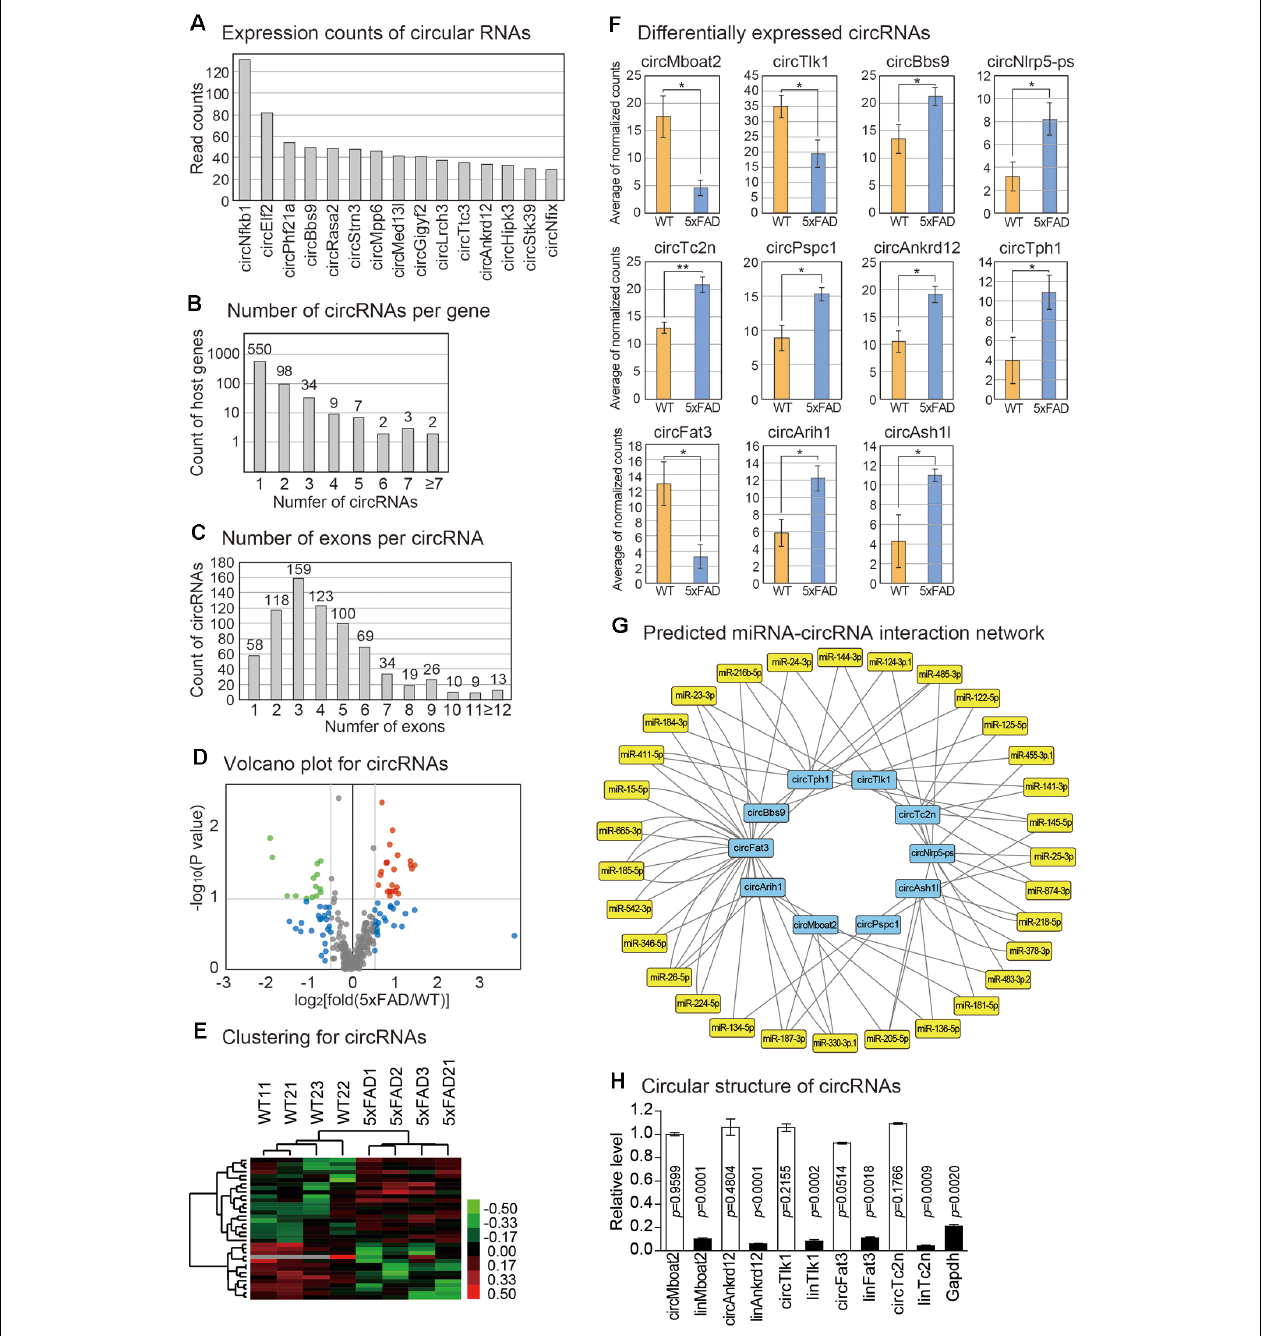
FIGURE 4 | Analysis of circRNA changes in the mouse pineal gland with AD. (A) Expression counts of 15 highly expressed circRNAs in the pineal glands. The average read counts among the wild type and 5xFAD samples were calculated. (B) Distribution of the number of circRNAs produced from each host gene. (C) Distribution of the number of exons used to produce each circRNA. (D) Volcano plot for circRNAs. Those genes with values of P < 0.1 and those with expression changes > 50% in the 5xFAD group compared to the wild type group are indicated. (E) Clustering of circRNAs. For the selected circRNAs from (D) , unsupervised hierarchical clustering was performed. The color bar representing the expression difference between wild type and 5xFAD is shown. (F) Differentially expressed circRNAs between the pineal gland from the wild type and 5xFAD groups. A one-tailed t -test was applied to calculate the P -value ( ∗ < 0.05, ∗∗ < 0.01). (G) The circRNAs-miRNAs regulatory network. The regulatory relationship was predicted by the existence of a miRNA binding site in the circRNA sequence. (H) Confirmation of the circular structure of circRNAs by RNase R treatment. The data in Supplementary Figure S2B were used for the quantitation. The white bars indicate circRNAs while the filled bars are linear RNAs. Expression change of each circRNA between untreated and RNase R-treated samples was calculated. P -value was calculated with a two-tailed t -test.